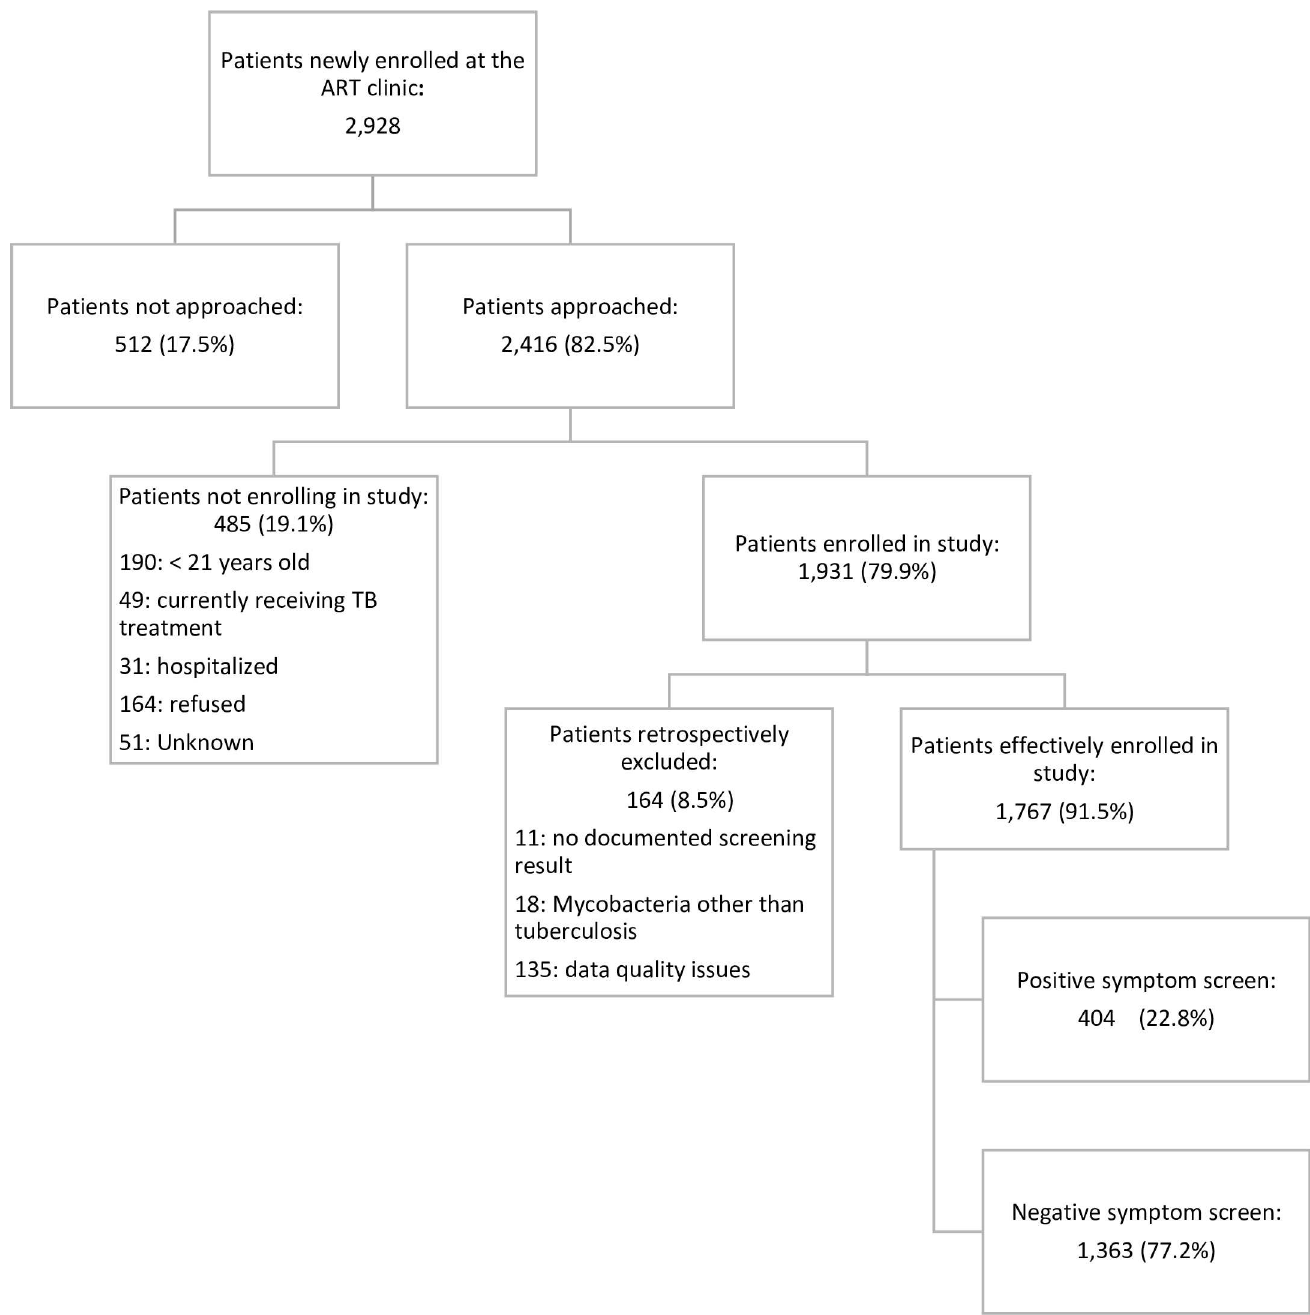
Fig 1. Flow Diagram of Patient Enrollment.